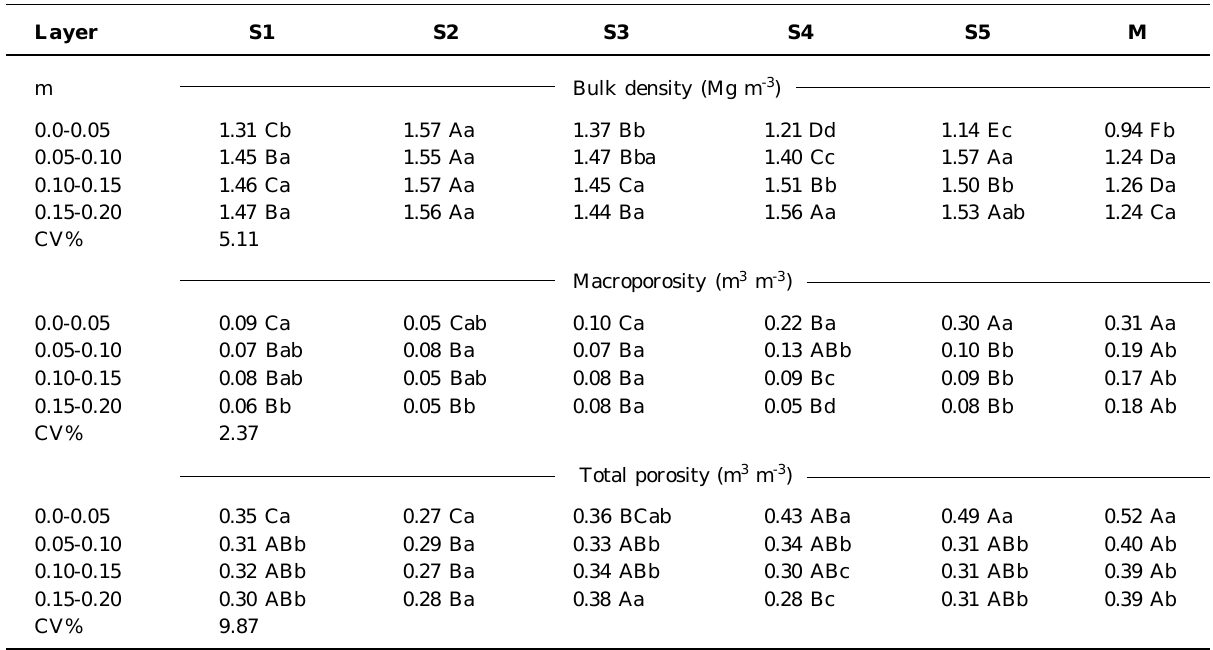
Table 2. Bulk density, macroporosity and total porosity in four layers of different crop rotation systems in crop-livestock